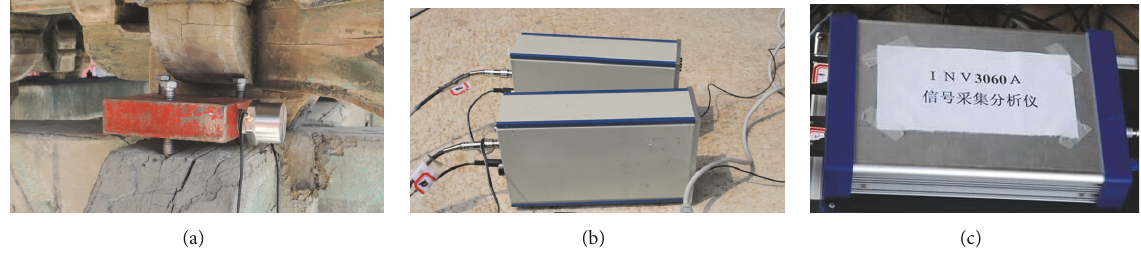
Figure 19: Field test equipment: (a) accelerometer; (b) amplifier; (c) data acquisition